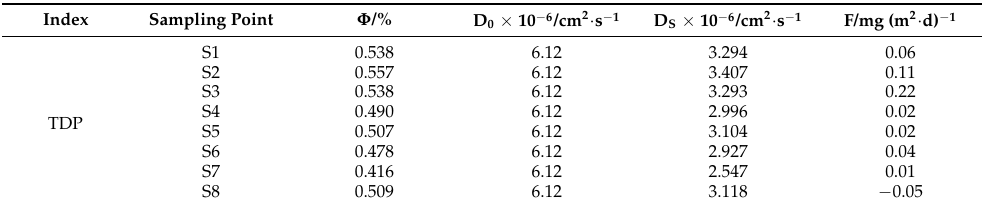
Table 7. Porosity, diffusion coefficient and diffusion flux of TDP at the sediment–water interface of the Yitong